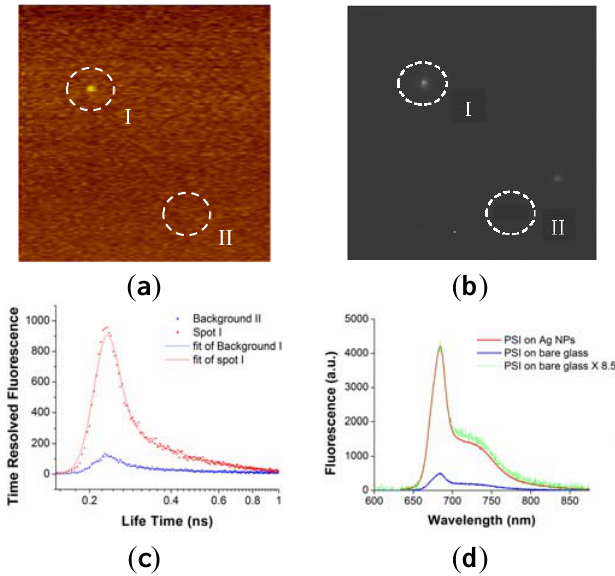
Figure 7. Correlation of PSI fluorescence and metal nanoparticle dark field